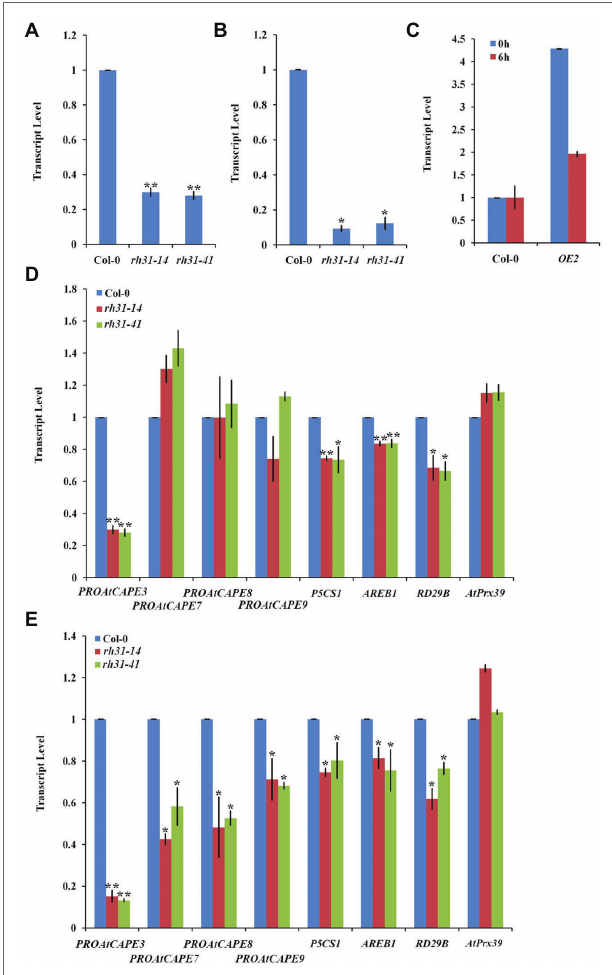
FIGURE 7 | PROAtCAPE3 and salt-inducible gene expression analysis under normal and salt-stress conditions. (A,B) Quantitative RT-PCR of PROAtCAPE3 in rh31 and Col-0 lines under normal growth condition (A) or after treatment with 150 mM NaCl for 24 h (B) . (C) Quantitative RT-PCR of PROAtCAPE3 in RH31 overexpression ( OE 2) and Col-0 lines under normal growth condition or after treatment with 150 mM NaCl for 6 h. (D,E) Quantitative RT-PCR of PROAtCAPE3 and salt-inducible genes in rh31 and Col-0 lines under normal growth condition (D) or after treatment with 150 mM NaCl for 3 h (E) . Each value indicates relative quantity, with the genes expressed in Col-0 set at 1.0. * p < 0.05 and ** p < 0.01 (Student’s t -test) indicate significant differences between mutants or transgenic lines and Col-0 plants. Error bars indicate the standard error for the average of three independent